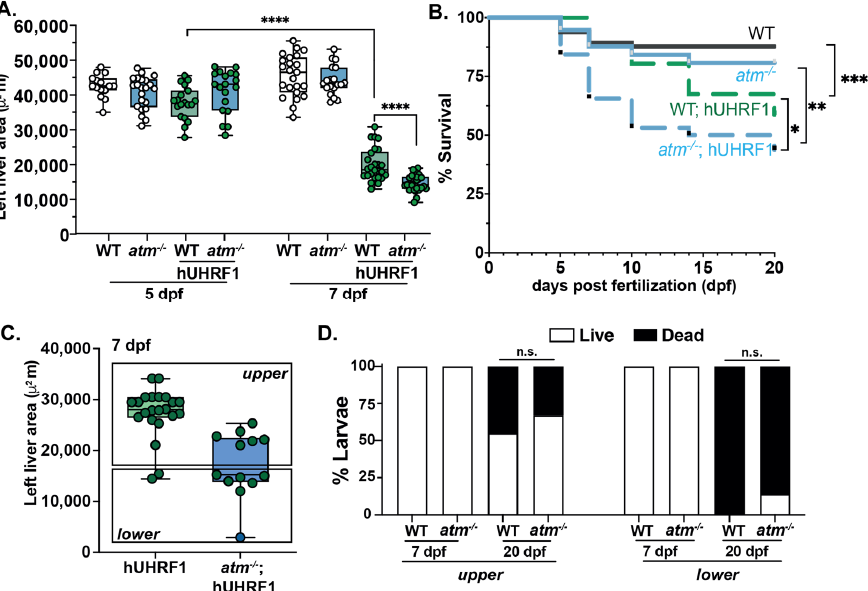
Figure 5. atm mutation enhanced the small liver phenotype and larval death in Tg (fabp10a:hUHRF1- EGFP) larvae. ( A ) Liver size of hUHRF1 and atm − / − ; hUHRF1 larvae compared to